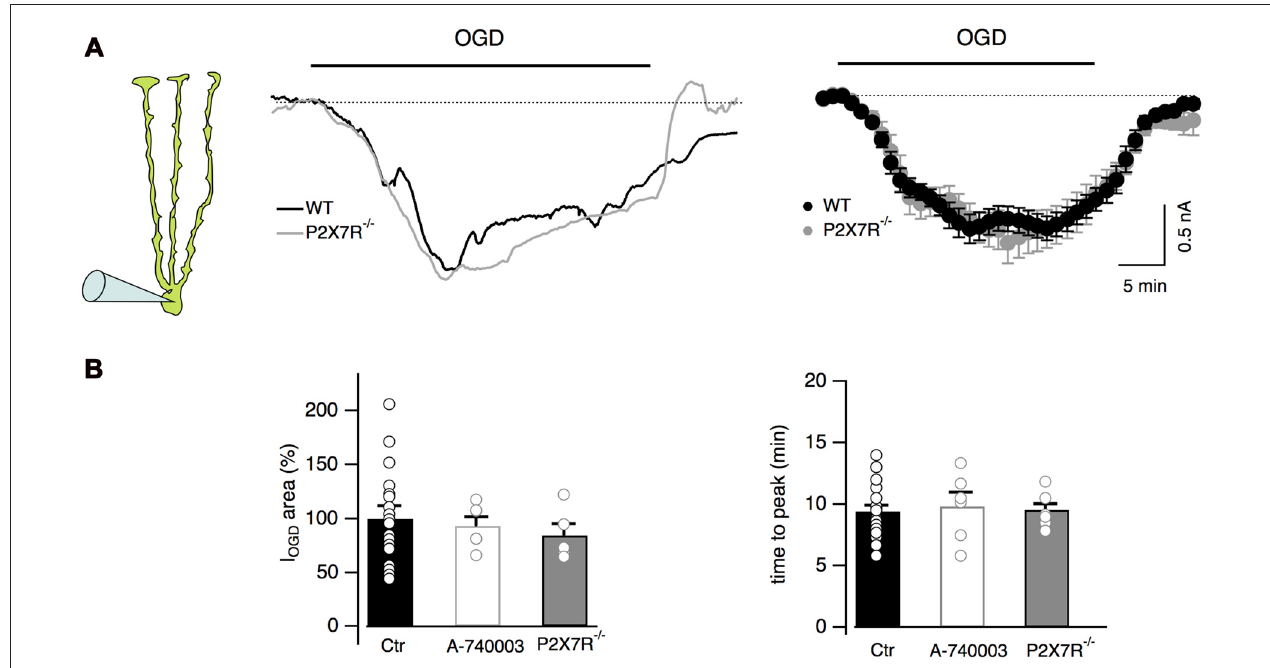
FIGURE 5 | P2X7 receptor activation is not observed during OGD. (A) Representative currents from a Bergmann glial cell in wild type and P2X7R − / − mice. Mean currents are shown at the right ( n = 19 and n = 8 from wild type and P2X7R − / − mice respectively). (B) No statistical differences are observed in the electrical charge or in the time to peak of I OGD among WT, P2X7R − / − mice and cells from wild-type mice treated with the P2X7R antagonist, A-740003 (10 µ M). For I OGD charge: n = 19 in WT, n = 6 in A-740003 ( P = 0.4) and n = 5 in P2X7R − / − ( P = 0.91); for time to peak: n = 23 in WT, n = 6 in A-740003 ( P = 0.68) and n = 7 in P2X7R − / − ( P =